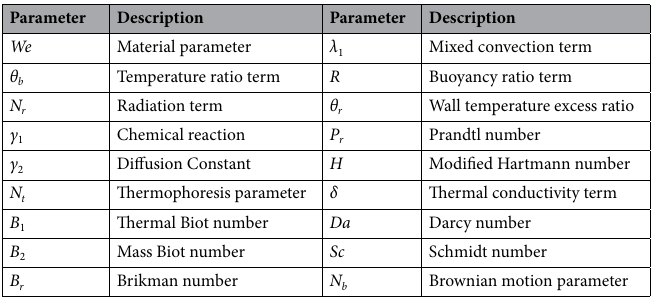
Table 2. lists of the evolving physical quantities that join the dimensionless governing